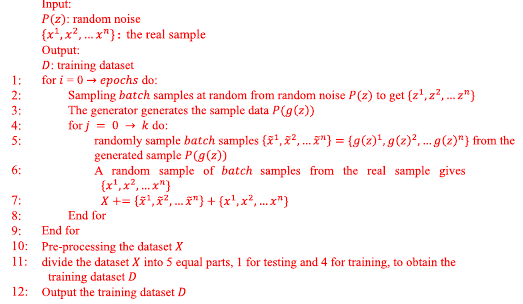
Algorithm 1 is DCGAN MODEL TRAINING, based on DCGAN, to solve the data sample balancing problem.